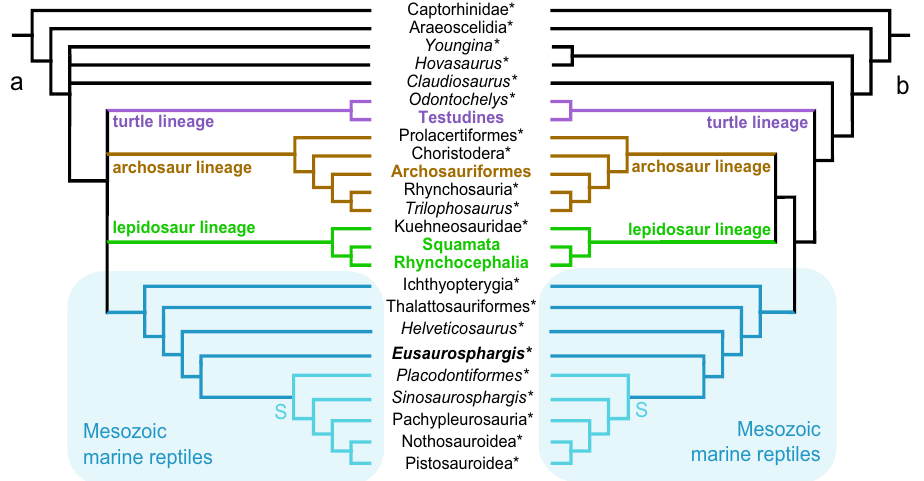
Figure 12. Phylogenetic analyses of diapsid reptilian lineages, showing the position of Eusaurosphargis dalsassoi among the Mesozoic marine reptiles. The three crown-group lineages of modern reptiles and the Mesozoic marine reptilian lineages are marked in colours; extinct taxa are marked by a small asterisk. ( a ) Analysis 1, run with the updated scoring for E . dalsassoi in the first matrix 30 . ( b ) Analysis 8, run with the updated scoring for E . dalsassoi in the third matrix 30 , with ‘all zero ancestor’ (not shown) as outgroup. Note that once the ‘all zero ancestor’ is excluded from the analysis and Captorhinidae is chosen as an outgroup, the tree topology is congruent with that of ( a ). Sauropterygia